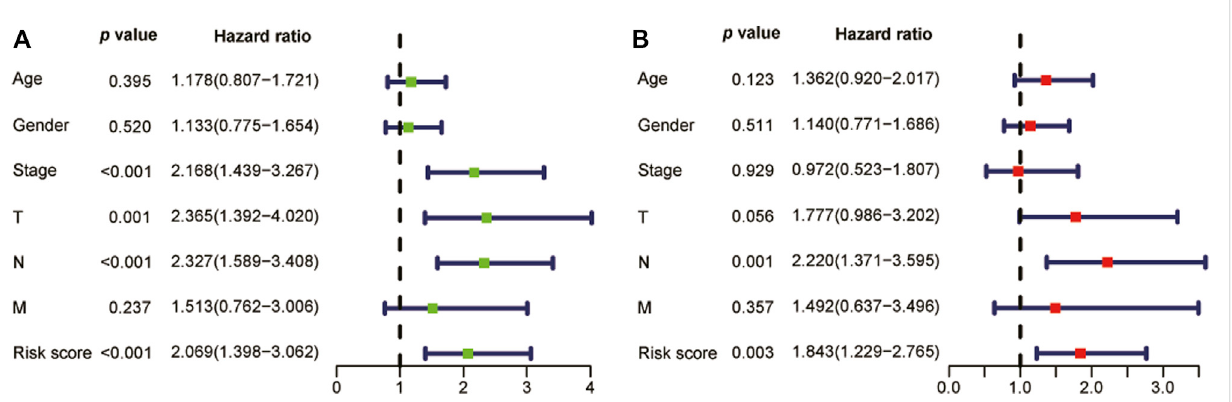
FIGURE 5 The univariateand multivariate Cox analysis analyses utilizing therisk score and clinical variables. (A) The univariateCox analysisresults showed that the risk score was highly associated with overall survival ( n = 453). (B) In LUAD patients, the lncRNA signature, as shown in the multivariate Cox analysis, was determined to be an independent prognostic factor ( n = 453). LUAD: Lung adenocarcinoma.